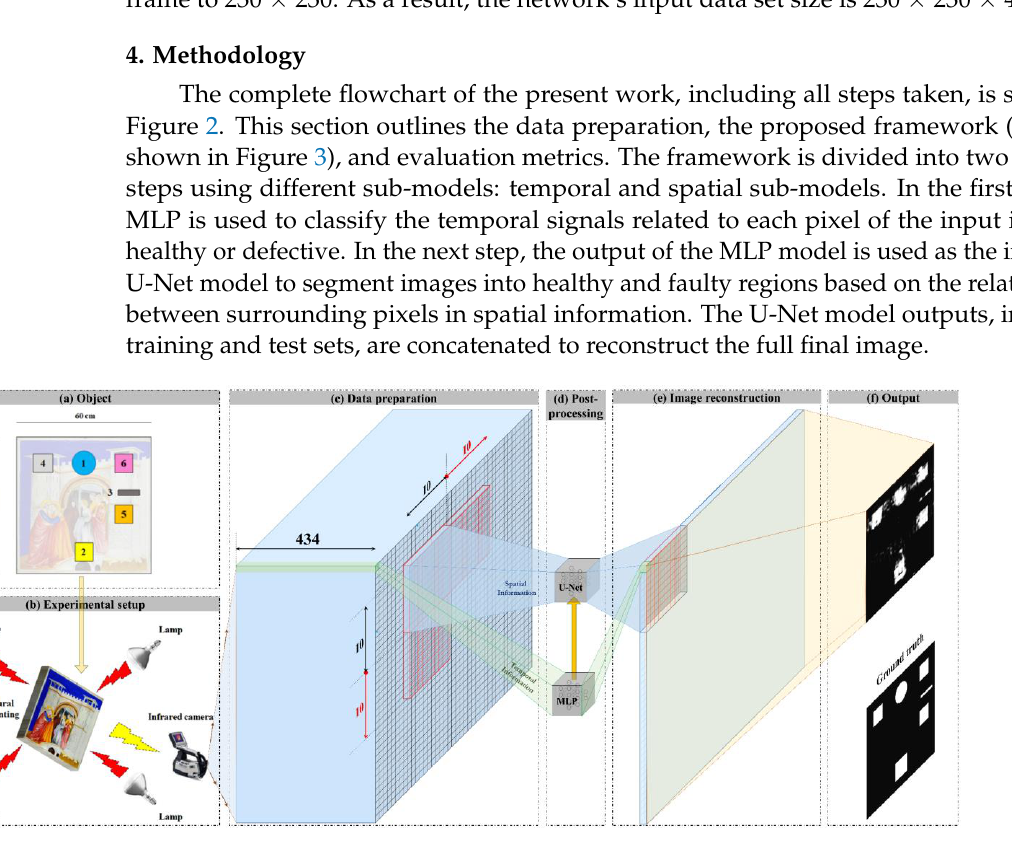
Figure 2. The complete flowchart of the current work includes: ( a ) object preparation for inspection, ( b ) configuration of the experimental set-up, ( c ) data preparation, ( d ) post-processing algorithm, ( e ) image reconstruction, and ( f )